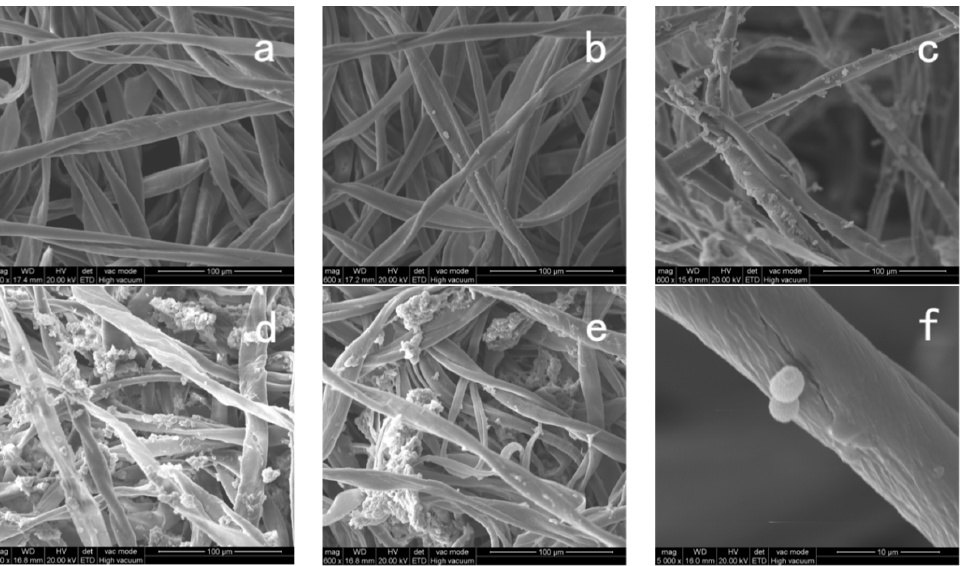
Figure 11. Sem images of ( a ) P 0g/L , ( b ) P 5g/L , ( c ) P 10g/L , ( d ) P 15g/L , ( e ) P 20g/L at 600 × magnification and ( f ) P 5g/L at magnification of 5000 × .